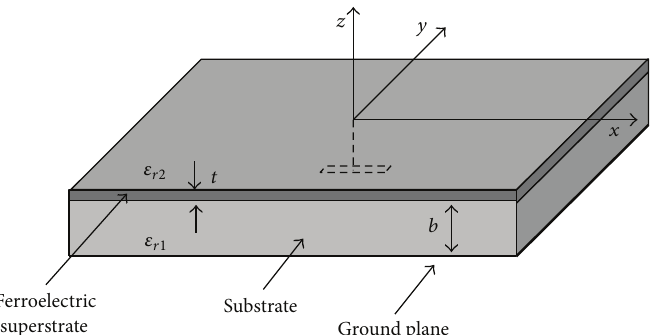
Figure 1: Planar substrate-superstrate configuration excited by a magnetic dipole over the ground plane with the relevant geometric and physical parameters.